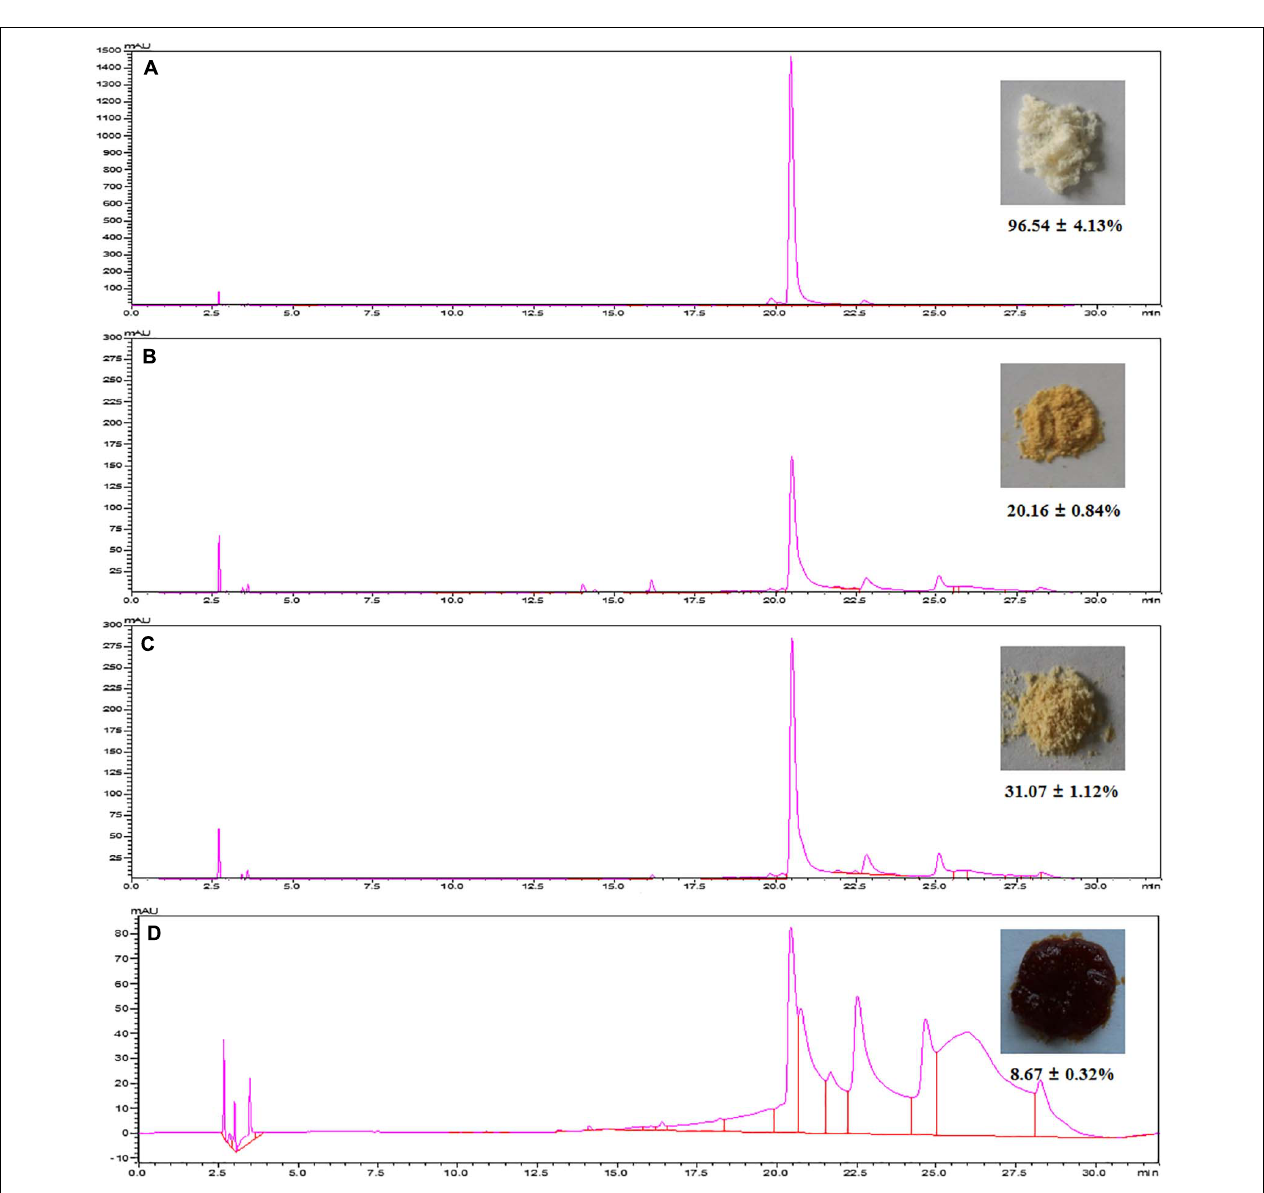
FIGURE 6 | Chromatograms and the pictures of the final HSAF products with different methods. (A) The preparative HPLC; (B) the NKA adsorption with 80% ethanol solution elution; (C) the NKA adsorption with stepwise elution; (D) ethyl acetate